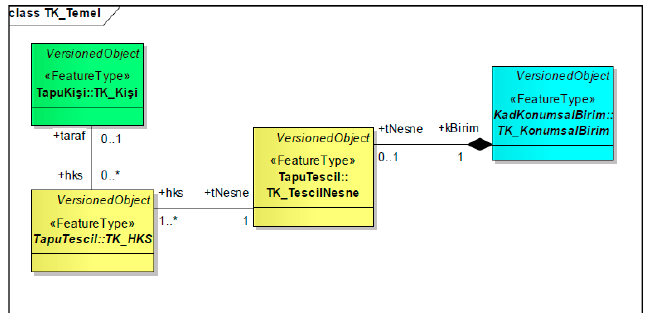
Figure 4. Basic classes of TK (Tapu Kadastro) data theme and their relationships. Translation of some of the expressions: ‘KonumsalBirim’ = ‘Spatial Units’, ‘TescilNesne’ = ‘Registration Object’, ‘HKS’ = ‘RRR’, ‘Ki ş i’ = ‘Person’, ‘Taraf’ = ‘Party’ [35].